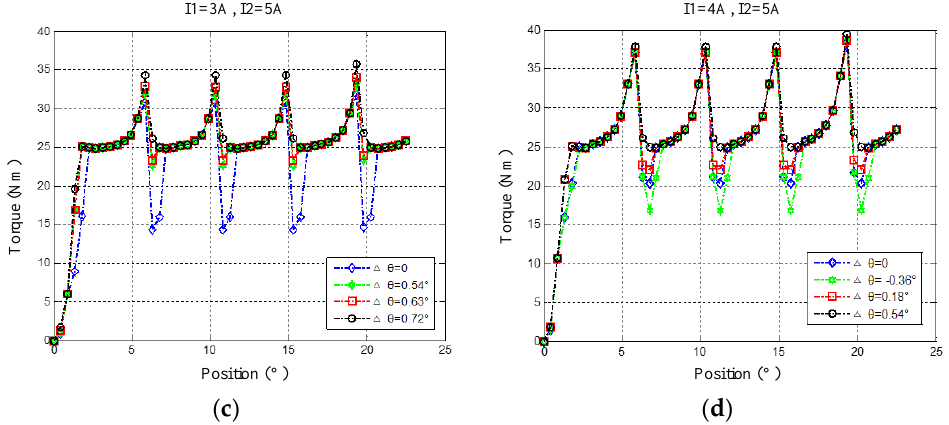
Figure 7. Torque characteristics: ( a ) I 1 = 1 A, c = 0.2; ( b ) I 1 = 2A, c = 0.4; ( c ) I 1 = 3 A, c = 0.6; ( d ) I 1 = 4 A, c = 0.8.